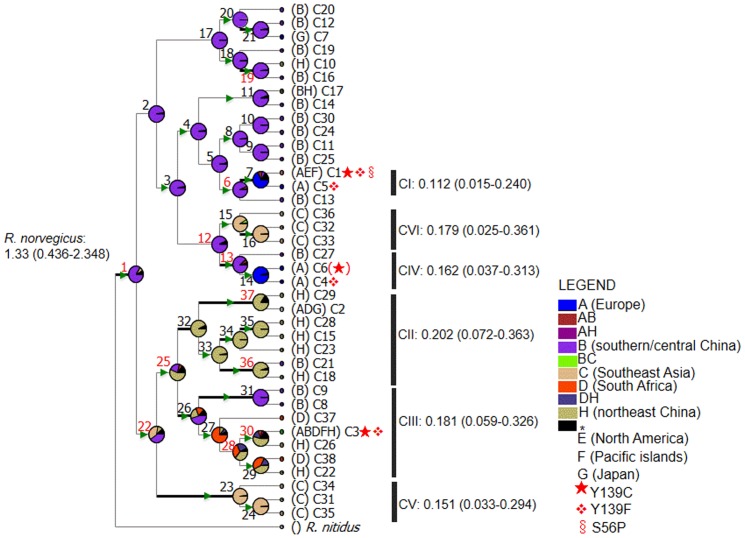
Ancestral area reconstruction based on cyt-b haplotypes.Pie charts on each node show the probability of each ancestral haplotype to have occurred at an inferred ancestral geographic location using the RASP method. Locations are shown in different colors and denoted with alphabetic letters A-H. Probabilities <5% were lumped together as “*”. Node numbers are shown along branches (red), indicating differences between methods (c.f. methods and Table S2). Green arrows indicate possible dispersal events. Black thick branches indicate posterior possibilities ≥0.69. Red symbols mark haplotypes found in animals carrying Y139C, Y139F, and S56P mutations in Vkorc1. Estimated mean divergence times and 95% highest posterior densities (in parentheses) are shown next to each of clades CI-CVI and the node supporting monophyly of the Norway rat.